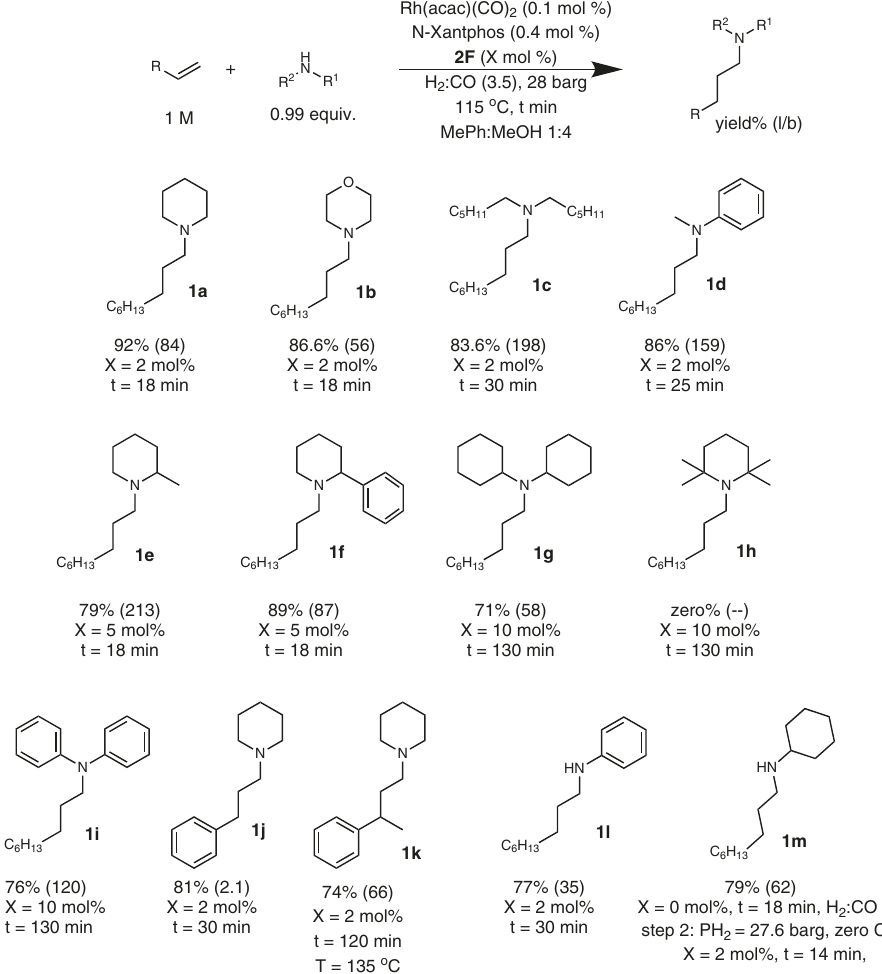
Fig. 4 In- fl ow HAM substrate scope screening with the cooperative catalyst. Rh and N-Xantphos loading were 0.1 and 0.4 mol%, respectively. For each in- fl ow HAM reaction, 4 ml of the ef fl uent liquid was collected, and the product was isolated and puri fi ed for analysis. The reported yields are the isolated yields, and the l/b values are measured by gas chromatography – mass spectrometry